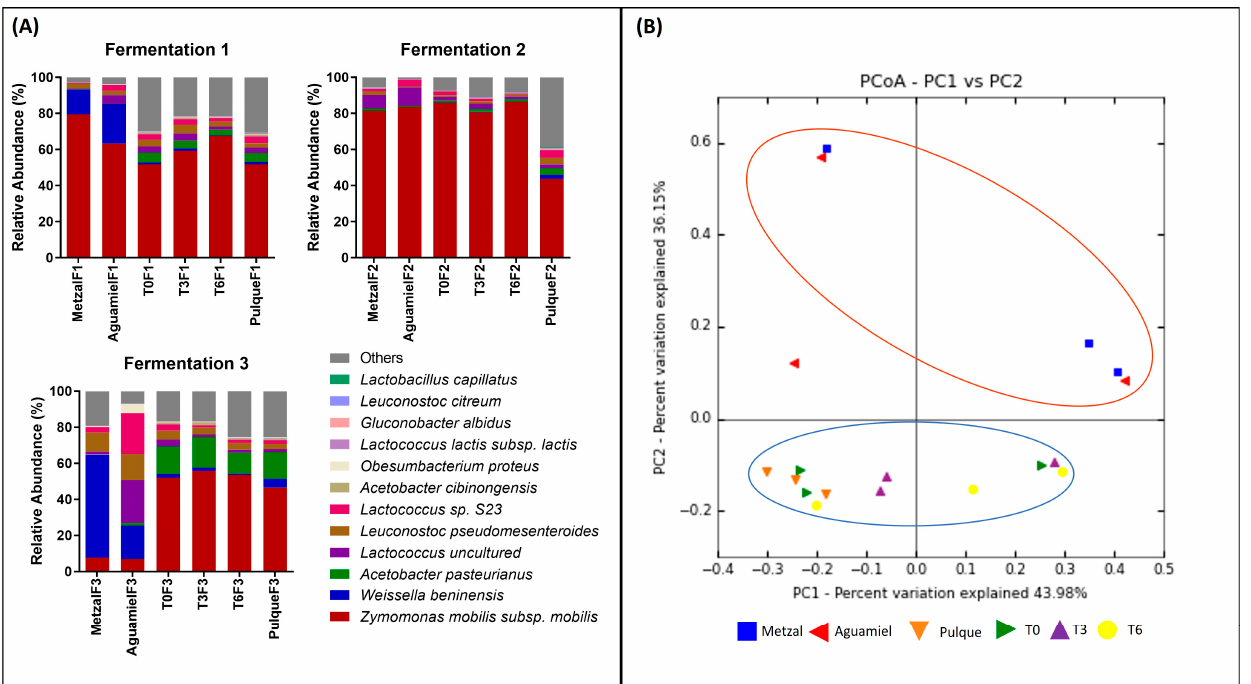
Figure 4. Bacteria diversity during pulque fermentation. ( A ) The relative abundance profile of Bacteria is shown for each of the three fermentations using the SILVA132 database. ( B ) Bacteria PCoA plots based on the Bray–Curtis analysis. The red circle shows the association between AM and metzal samples, whereas the blue circle shows the association between the fermentation stages. The graphs represent the microorganisms with more than 0.01% of relative abundance . The complete relationship of those microorganisms included in the group named Others is shown in the Supplementary Files (Table S1). Table 2. Alpha diversity values.